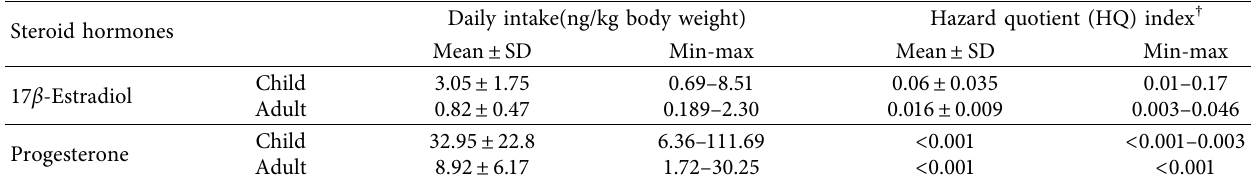
Table 6: Calculation of HQ index based on the average of daily intake of steroid hormones by milk consumption in Hamadan, Iran. Steroid